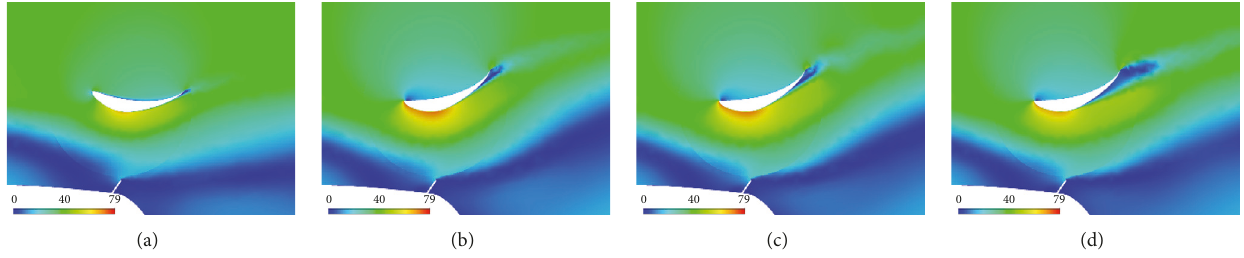
Figure 12: Contours of the velocity in the symmetry plane while the wing is moved to 20 ∘ at the following time frames: (a) 0.25 s, (b) 0.35 s, (c) 0.40 s, and (d) 0.45